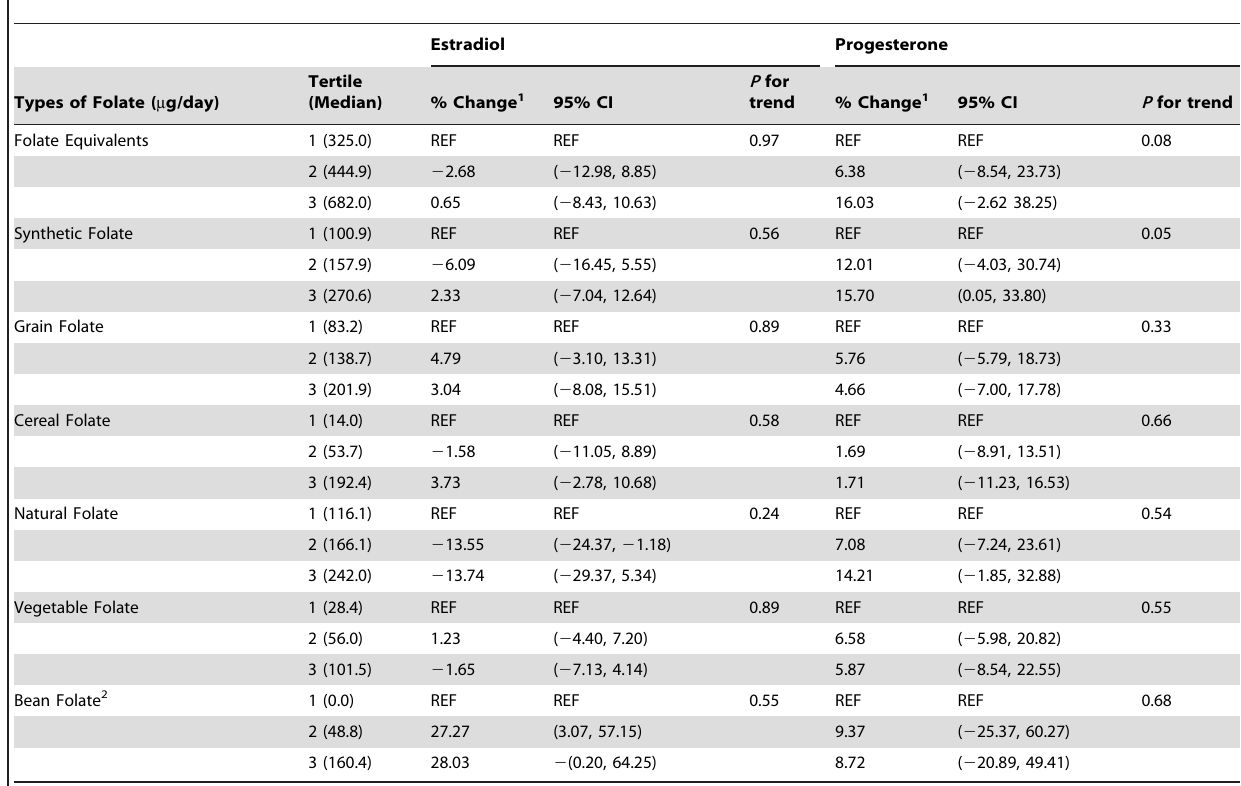
Table 3. Association between dietary folate intake and estradiol and progesterone in the BioCycle Study.